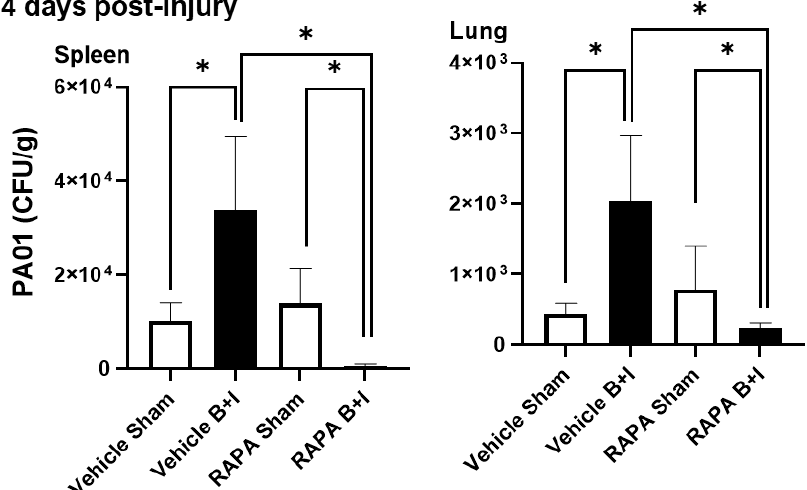
Figure 8. B+I injury, compared to sham injury, increases susceptibility to bacterial infections late after injury; susceptibility early and late after injury is differentially regulated by mTOR. Mice were administered either rapamycin or vehicle pretreatment for 7 days before receiving either B+I or sham injury (n = 12 per group). Surviving mice were i/v inoculated with Pseudomonas aeruginosa (strain PA01) 14 days after B+I or sham injury (n = 6 per group). After 24 h, spleen and lung were harvested and plated on agar to assess bacterial infection, and colony forming units (CFUs) calculated for each injury/treatment condition. In each case, data are presented +/ − SEM, with significance represented as * p < 0.05. These data are representative of three experiments.